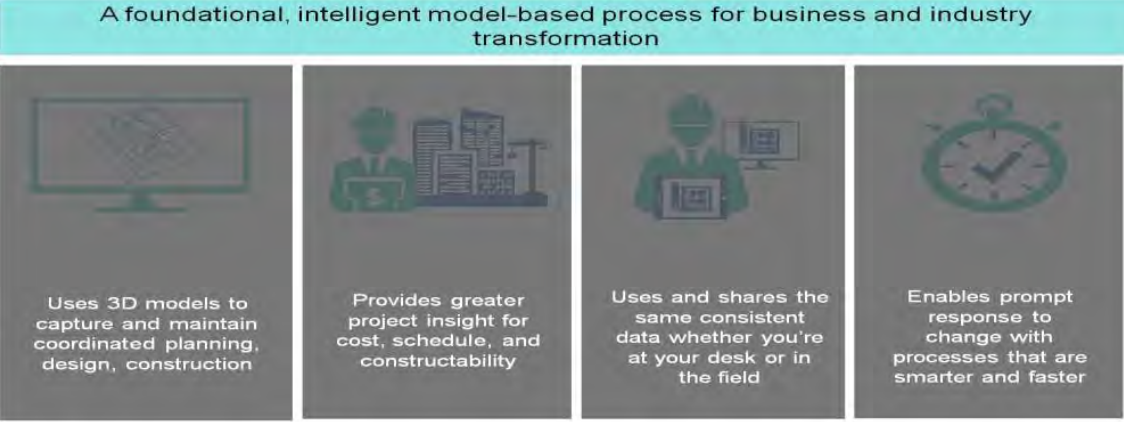
Figure 1. Building Information Modeling Characteristics